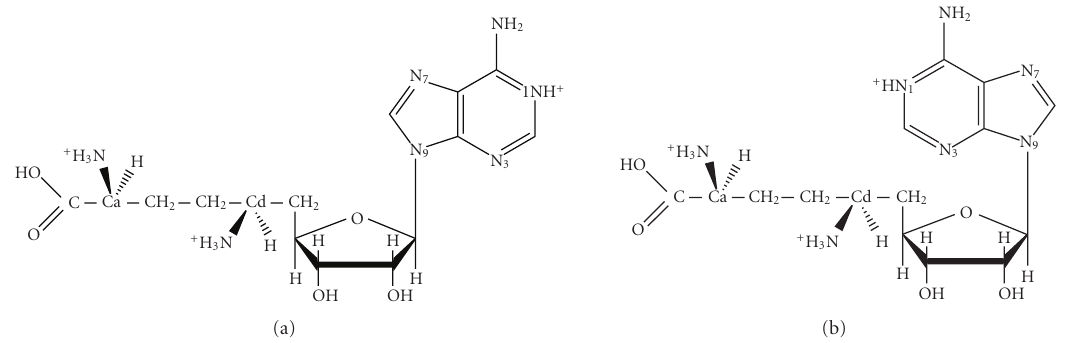
Figure 1: The fully protonated molecule of sinefungin in its two conformers, (a) anti and (b) syn .